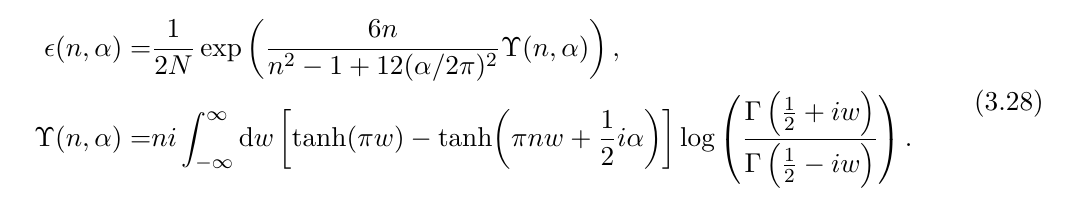
Figure 1 . Difference between the logarithm of the charged moments ∆ log Z n ( α ) ≡ log Z n ( α ) | log Z n ( α ) | , evaluated for a single interval of length, respectively, ‘ 2 = 0 . 3 L and ‘ 1 = 0 . 6 L , in r = ‘ 2 the spin sectors ν = 2 (left) and ν = 3 (right), with the temperature set to β = 3 L and N = 300 lattice sites. The blue continuous line uses the field theory prediction in eq. (3.20) while the symbols correspond to the exact results obtained through the techniques reported in appendix